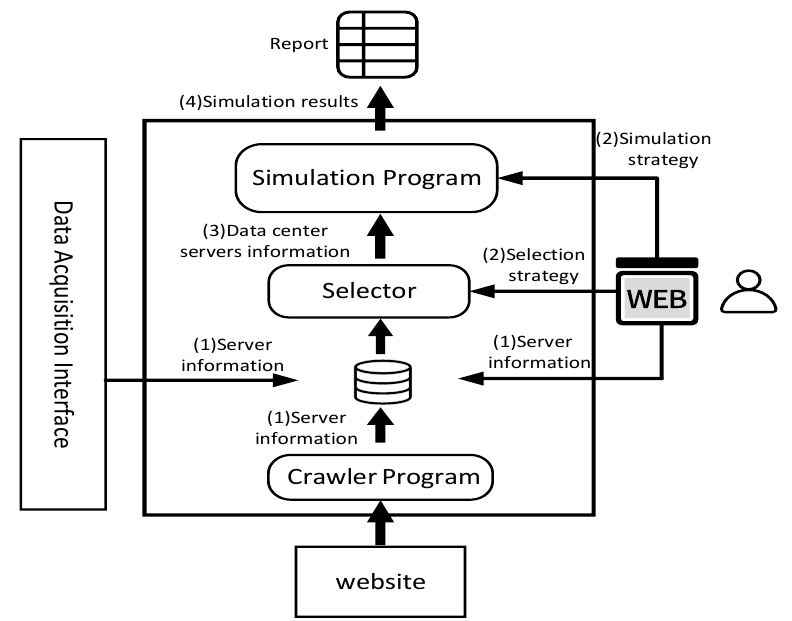
Figure 4. Escope Simulation Process.